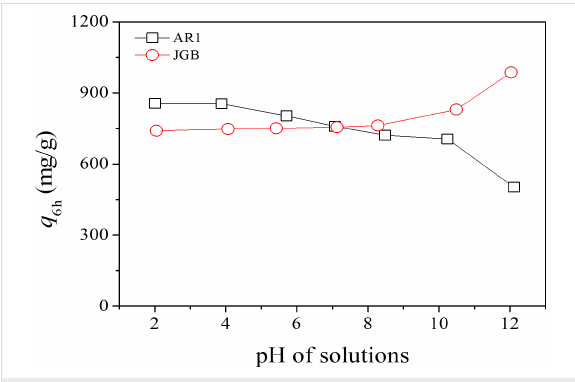
Figure 7: Effect of pH on the adsorbed amounts of AR1 and JGB over KOH-900.